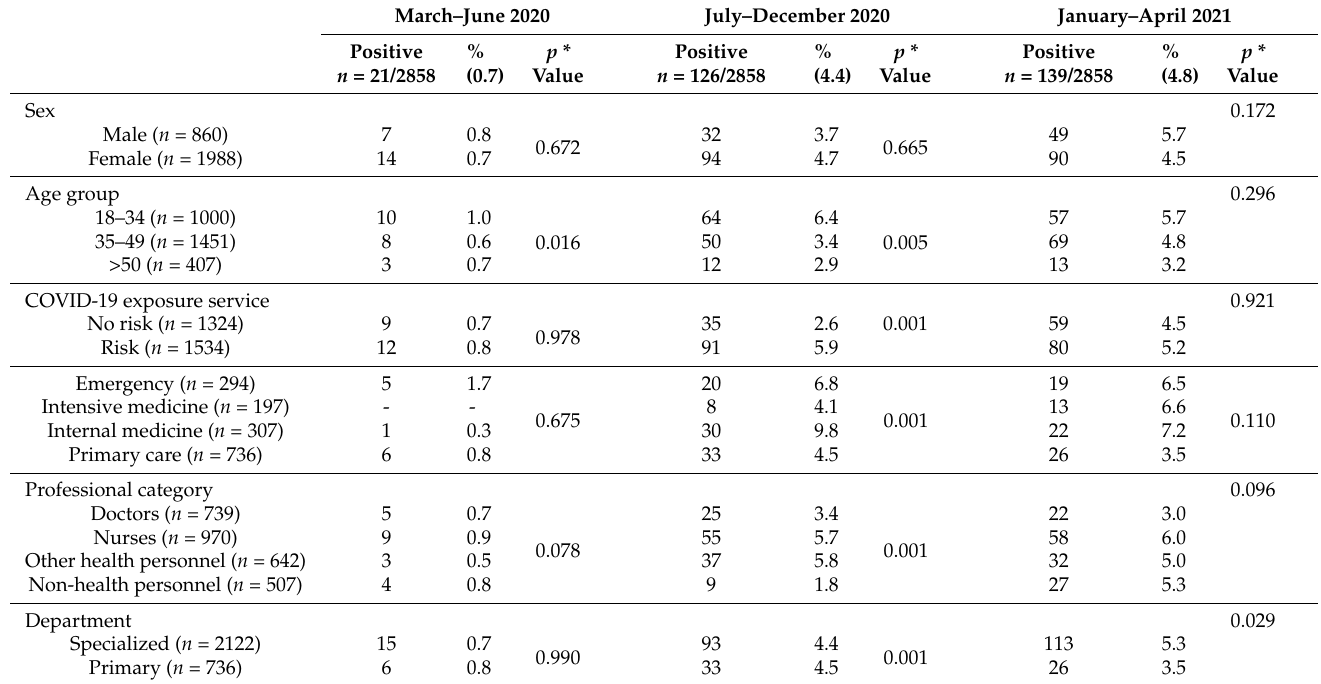
Table 4. Distribution of confirmed cases of SARS-CoV-2 infection in the healthcare professionals, according to epidemic waves.